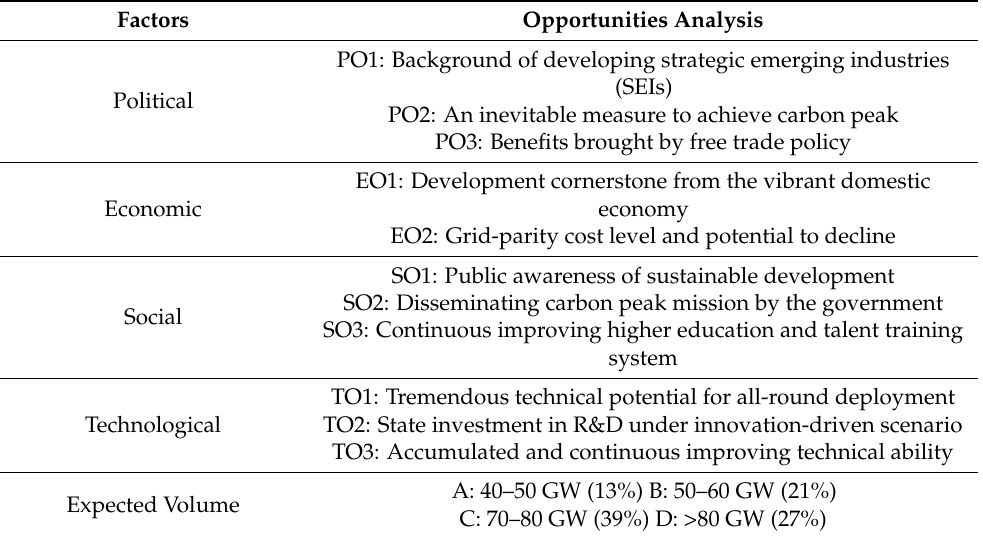
Table 3. The opportunities matrix of the PEST analysis for further development of solar PV power in